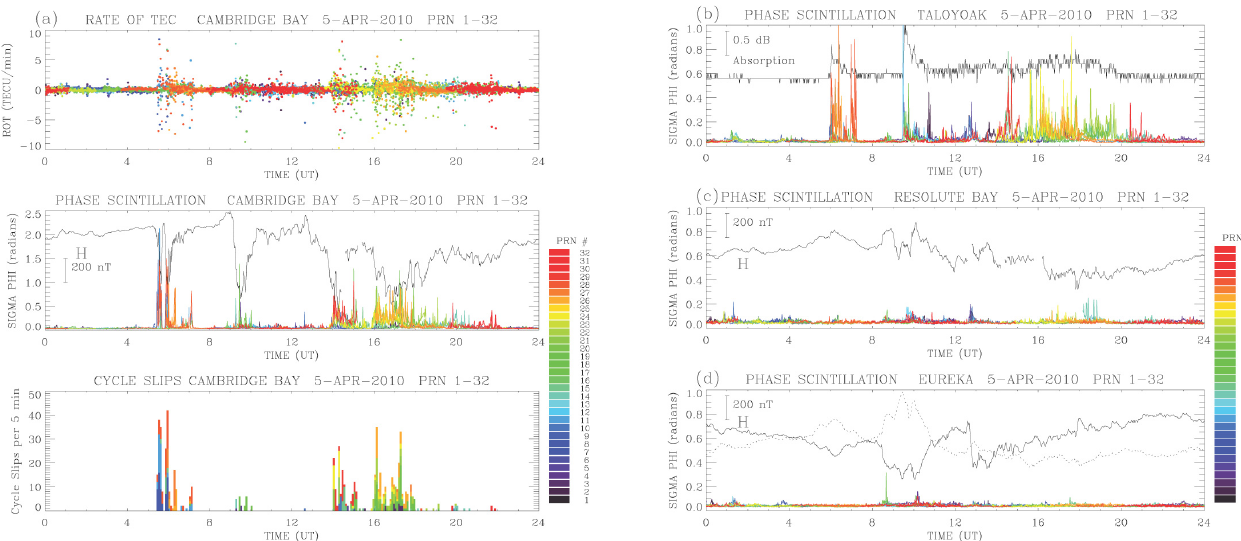
Fig. 5. (a) The rate of TEC (ROT) change, phase scintillation index σ 8 and number of cycle slips in Cambridge Bay observed at elevations above 20 ◦ on 5 April 2010. Only phase scintillation index σ 8 is shown for (b) Taloyoak, (c) Resolute Bay and (d) Eureka (note the different scale for σ 8 panels comparing to Cambridge Bay). Superposed in the scintillation panels is the H component of the ground magnetic field or riometer absorption measured at these stations. The H-component from Concordia station is shown in dotted line in panel (d) . 12:00 UT, both showed significantly smaller magnetic per- turbation amplitudes ( < 200 nT) in the Southern